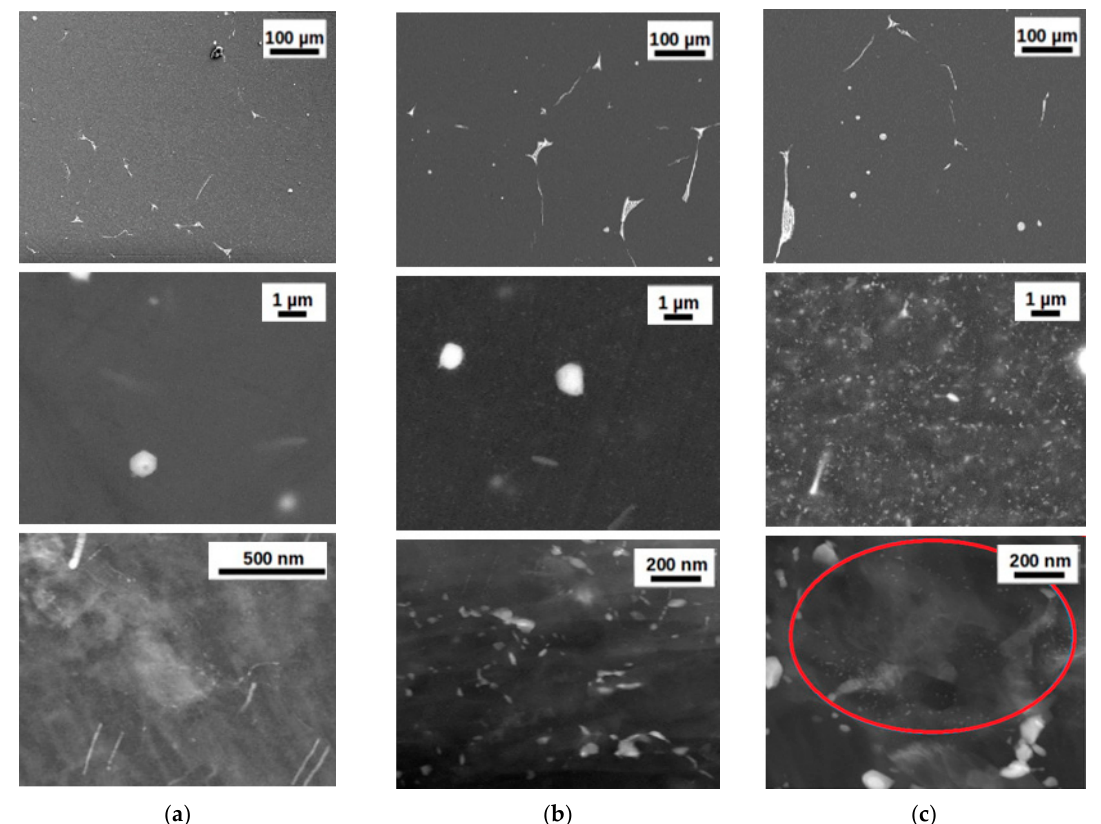
Figure 16. SEM (upper two rows) and STEM (bottom row) images of Mg5Zn0.3Ca samples (a) after HPT-processing; (b) after HPT and additional heat treatment at 100 °C for 24 h; and (c) after HPT and additional heat treatment at 125 °C for 24 h. HPT-processing was carried out by 0.5 rotations under 4 GPa pressure at RT.